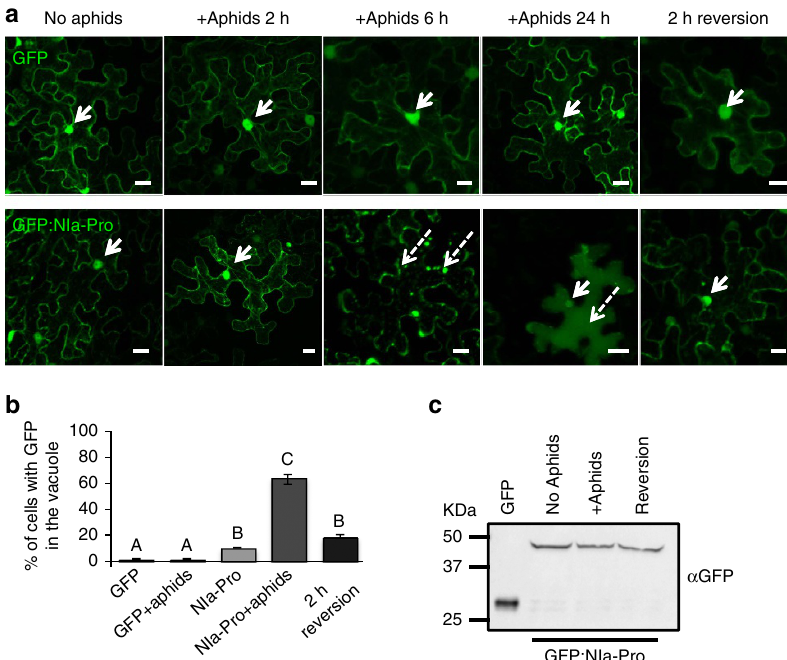
Figure 3 | NIa-Pro localization to the vacuole occurs only when aphids are given access to plants. ( a ) Images show confocal projections of N. benthamiana agroinfiltrated leaves with free GFP (top panel) or GFP:NIa-Pro (lower panel). Separate leaves were infested with aphids for 2, 6 or 24h (middle panels) and a set of leaves were left uninfested as a control (left panel). For the reversion (right panel), all aphids were removed after 24h of infestation, and the leaves were observed after a 2h recovery period. GFP:NIa-Pro relocalizes from the nucleus (white arrows) to form cytoplasmic aggregates after 6h (dashed arrows) and then diffuses into the vacuole after 24h (dashed arrow). When the aphids were removed, GFP:NIa-Pro was observed in the nucleus again (white arrow). The free GFP control does not show relocalization with any treatments. ( b ) The percentage of cells with GFP in the cytoplasm for each of the treatments. ( c ) The image represents a western blot from leaf extracts expressing free GFP or GFP:NIa-Pro before aphid infestation, after 24h of aphid infestation or after the 2h recovery period (reversion), and incubated with a GFP antibody. The western blot shows that the phenotype in the presence of aphids and after reversion is not due to the cleaved GFP. (mean ± s.e. of N ¼ 6, letters represent significant differences, ANOVA and Tukey’s honest significant difference post hoc , P o 0.05). Scale bars, 20 m